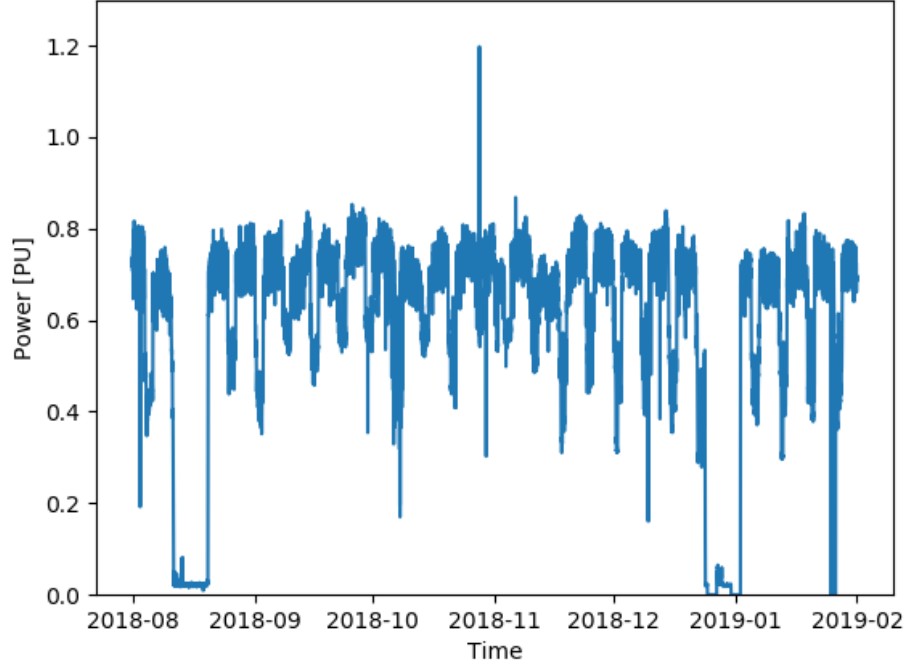
Figure 2. Original time series of the plant electrical load